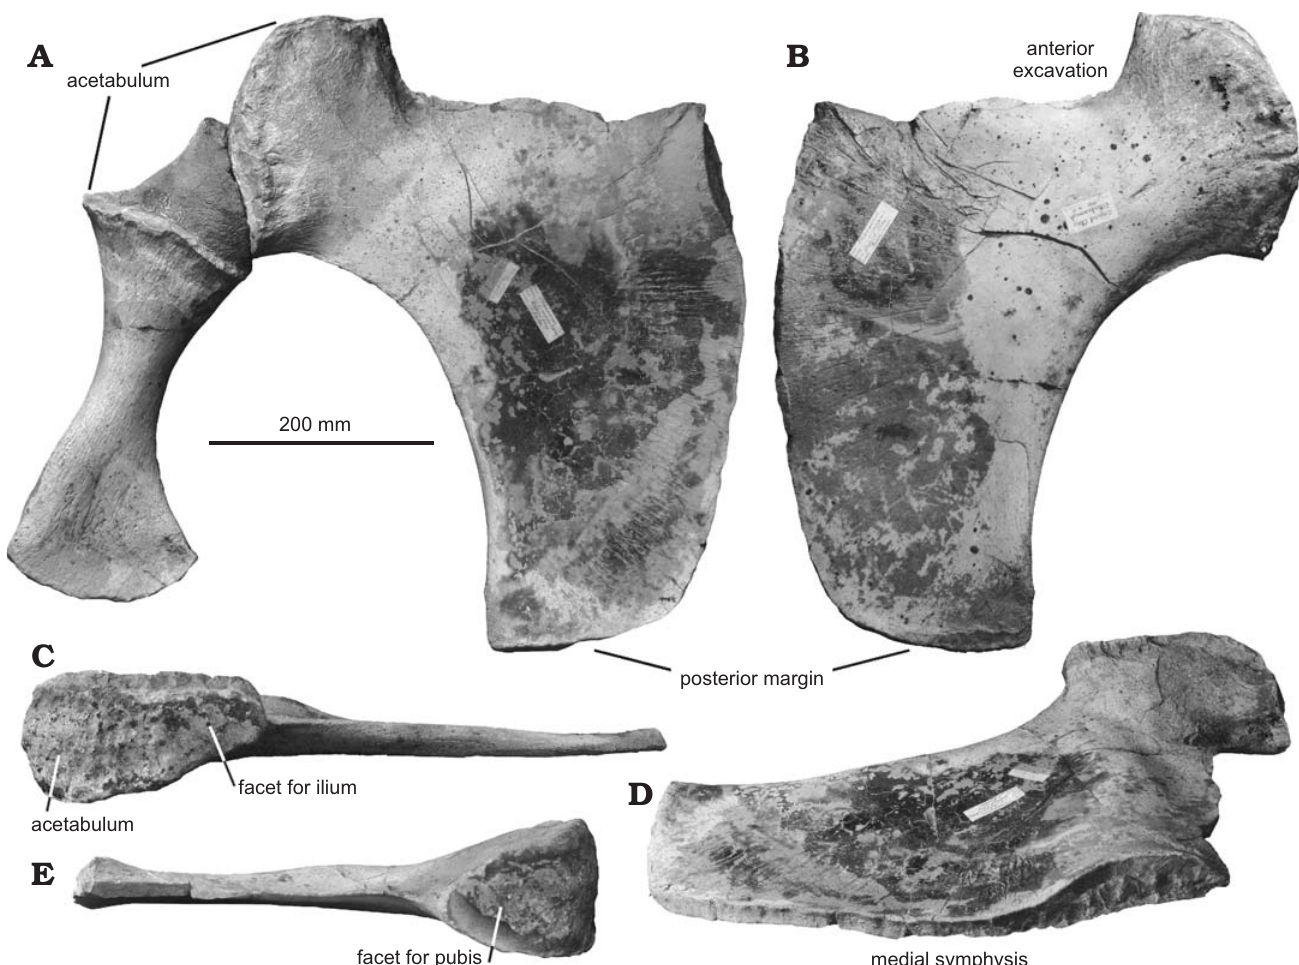
Fig. 3. Left ischium of the plesiosaur Rhomaleosauridae indet., CAMSM X.50215, from the Callovian Peterborough Member of Fletton, United Kingdom, in dorsal view (articulated with left ilium) ( A ), and ventral ( B ), lateral ( C ), dorsomedial ( D ), and anterior ( E )